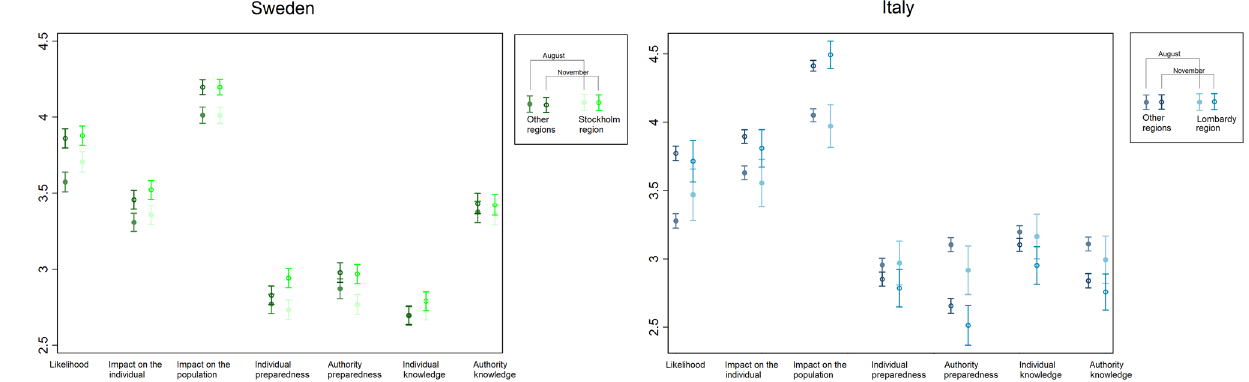
Figure 3. Means and 95% CIs for epidemic risk perception in Sweden and Italy by affected areas and period.